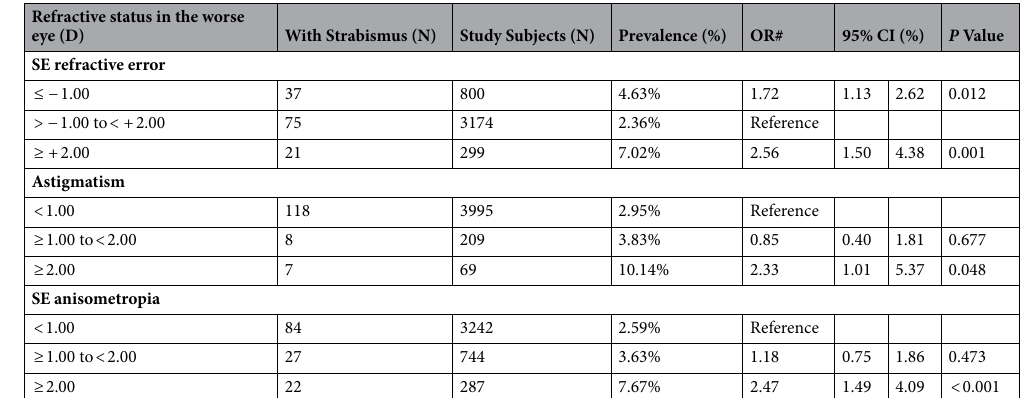
Table 3. Associations of strabismus with refractive errors. SE spherical equivalent; D diopters; CI confidence interval; OR odds ratio. # Adjusted for age, gender and refractive risk factors in the table in a multivariate logistic regression model.